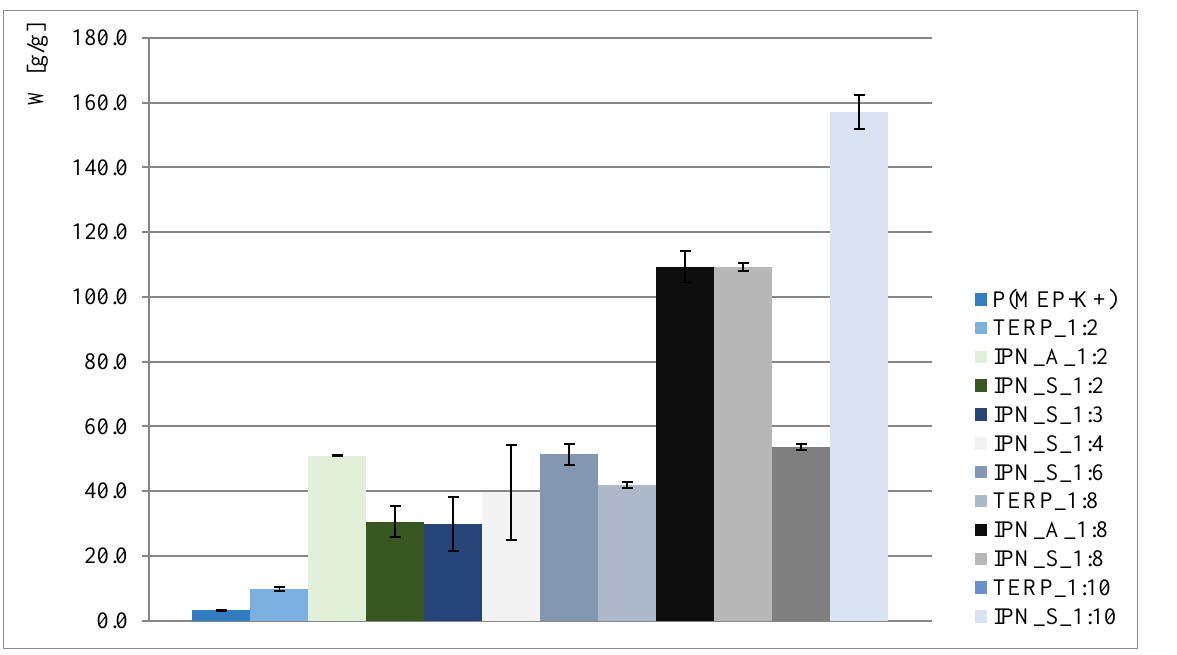
Figure 3. Water regain of polymers in potassium salt form.